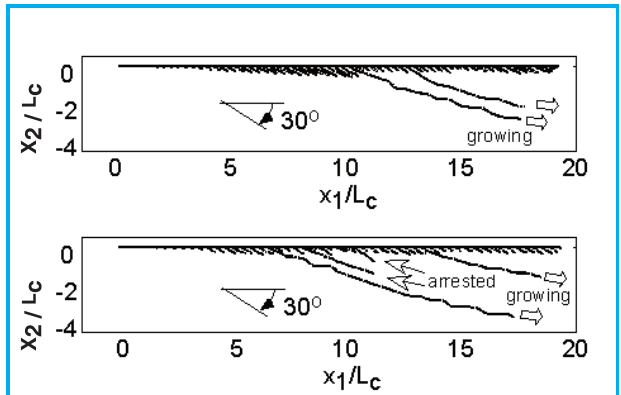
Figure 3. Examples of longer computation. We assume Δ B/Lc = 0.31 and 0.38 in the upper and lower graphs, respectively (after Ando and Yamashita, 2007) .